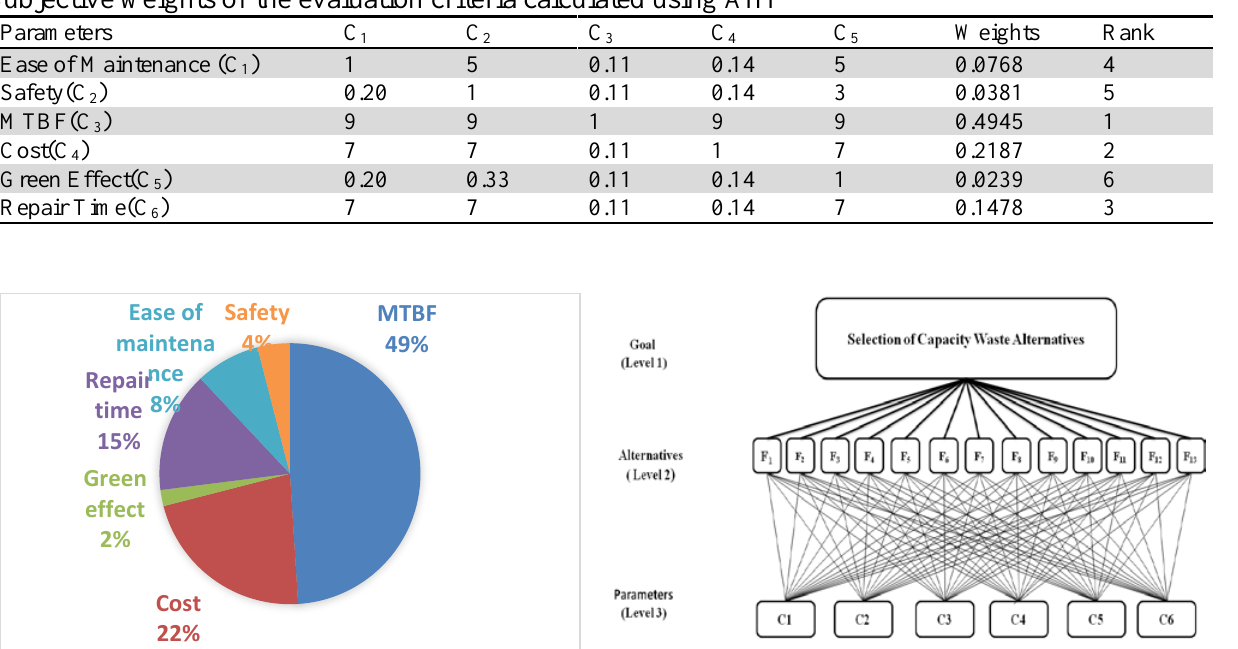
Fig. 4. The hierarchical structure for the selection of